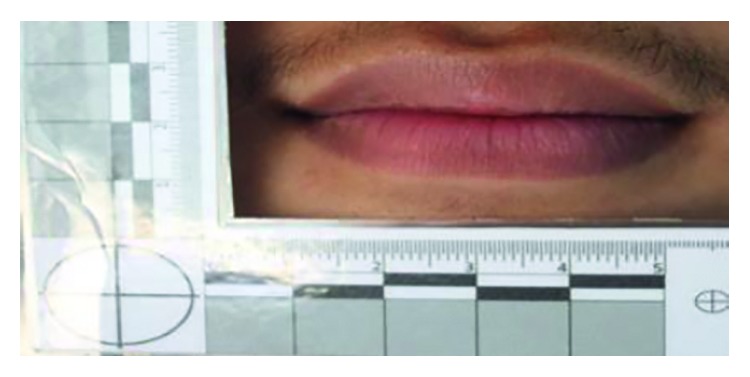
Photography technique of taking lip print [9].